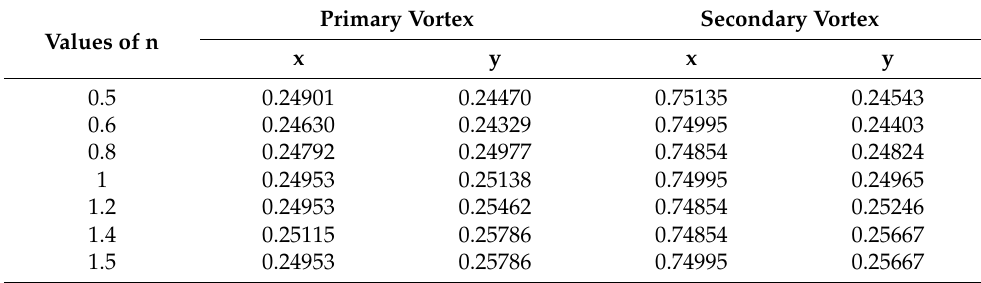
Table 5. Calculation of primary and secondary vortexes for varying n. Values of